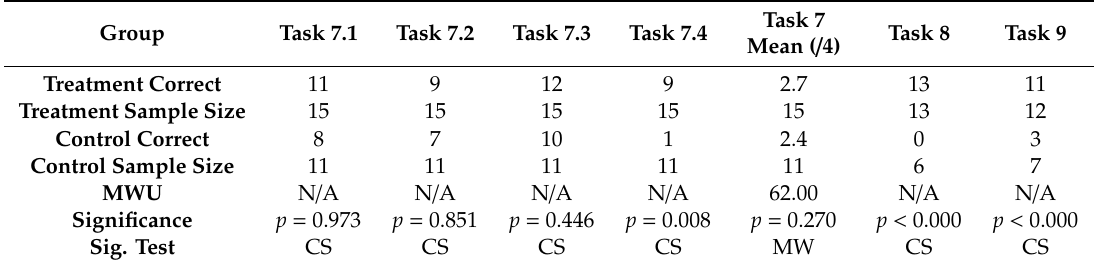
Table 5. Text-based emotion analysis